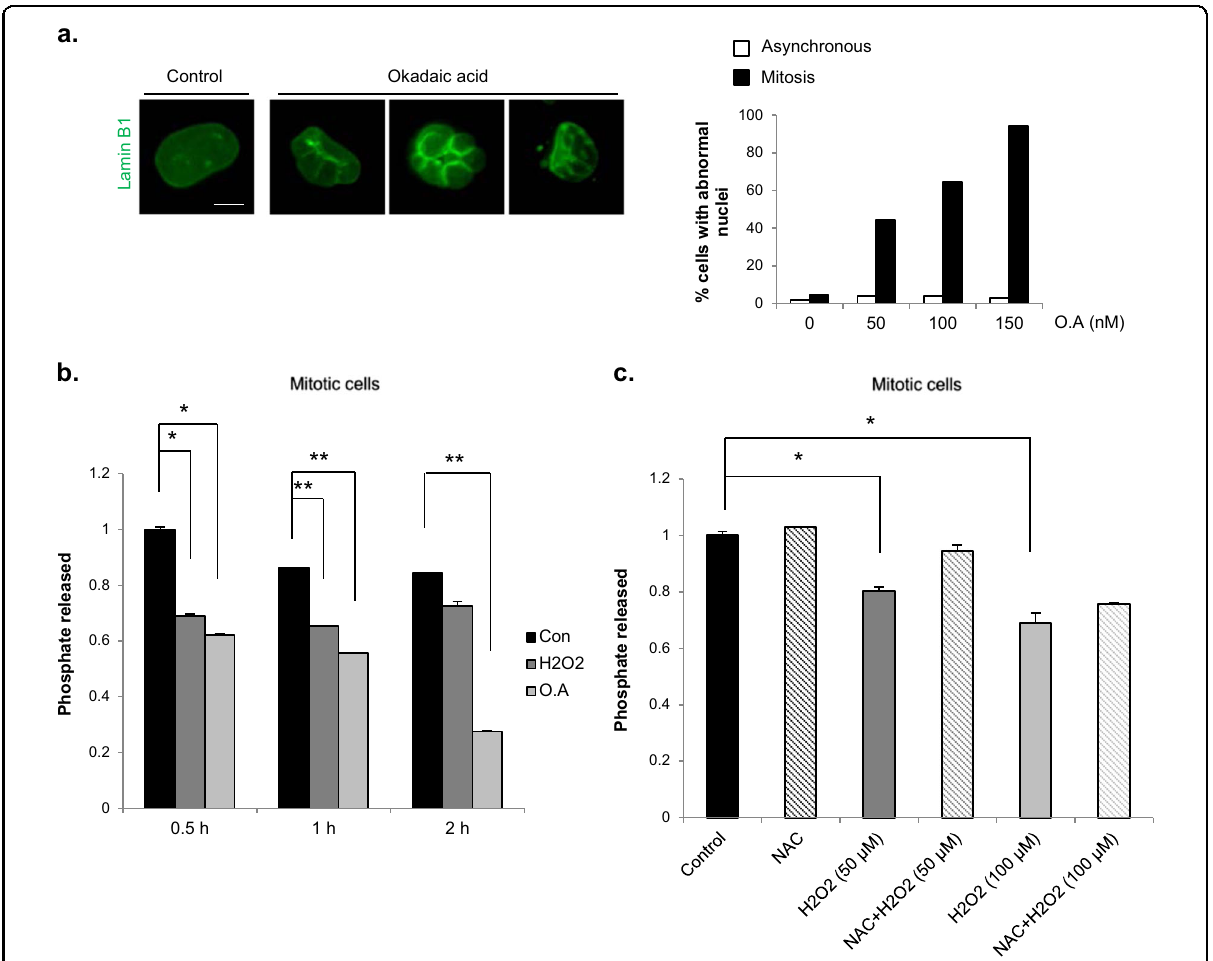
Fig. 4 Inhibition of protein phosphatase 2 A activity is involved in H 2 O 2 -induced abnormal nuclei formation. a Mitotic HeLa cells were treated with okadaic acid in a dose-dependent manner for 2 h. Cells were washed, and nuclear shape alterations were observed after 8 h. Left panel: Representative examples of the nuclear shape change in cells treated with okadaic acid. Scale bar: 10 μ m. Right panel: Percentage of cells with abnormal nuclear shapes resulting from treatment with okadaic acid (O.A) at the indicated concentrations ( n = 100). b Mitotic HeLa cells were treated with 100 μ M H 2 O 2 or 100 nM okadaic acid (O.A) for the indicated durations. The cells were harvested, and PP2A activity was determined using the PP2A activity assay kit from R&D Systems. The results are shown as the means ± SDs of three independent experiments. * P < 0.05; ** P < 0.01 by Student ’ s t -test. c Cells were pretreated (NAC + H 2 O 2 ) or not pretreated (H 2 O 2 ) with NAC for 30 min before H 2 O 2 treatment. Mitotic cells were isolated through shake-off and treated with or without H 2 O 2 for 30 min. The cells were harvested, and PP2A activity was determined using the PP2A activity assay kit. The results are shown as the means ± SDs of three independent experiments. * P < 0.05 by Student ’ s t